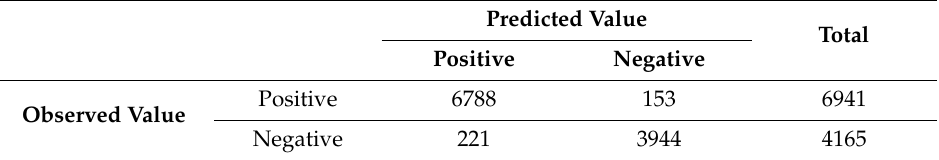
Table 2. The confusion matrix of the ResNet-101 + FPN model (one stage).